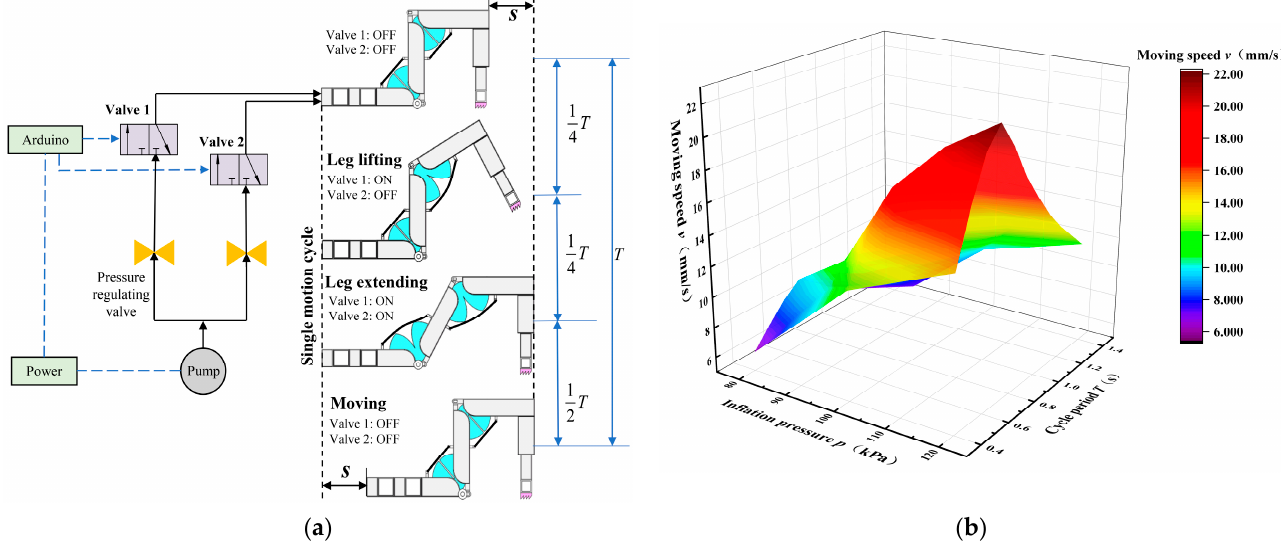
Figure 11. Locomotion test of single ‐ legged soft arthropod robot. ( a ) Locomotion principle; ( b ) The influence of pressure and period on moving speed.